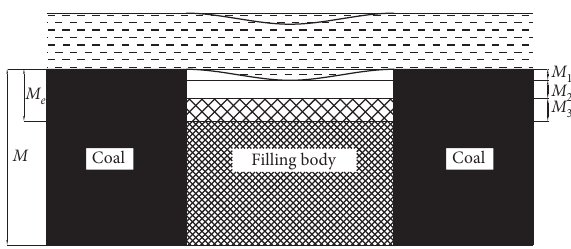
Figure 6: Schematic diagram of equivalent mining height in backfill mining.